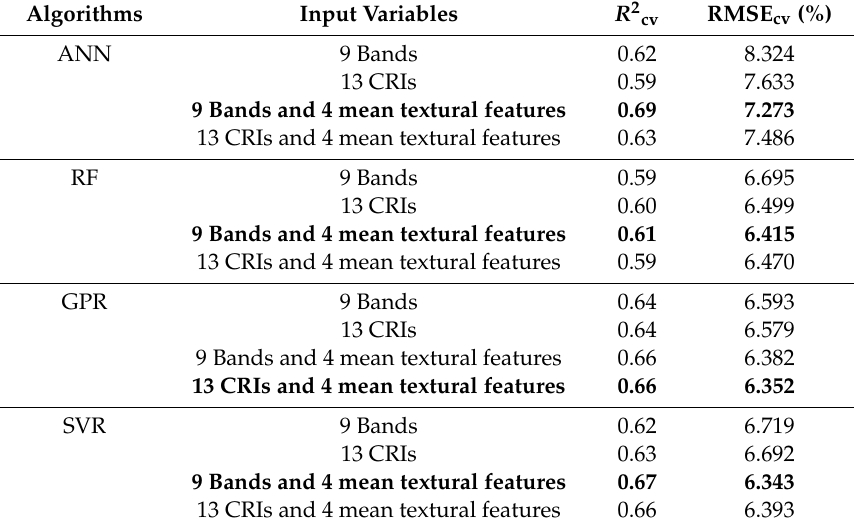
Table 5. Performance of artificial neural network (ANN), Gaussian process regression (GPR), support vector regression (SVR), and random forest (RF) associated with four groups of input predictors on CRC estimation. The best-performing input variable combination for each algorithm is highlighted in